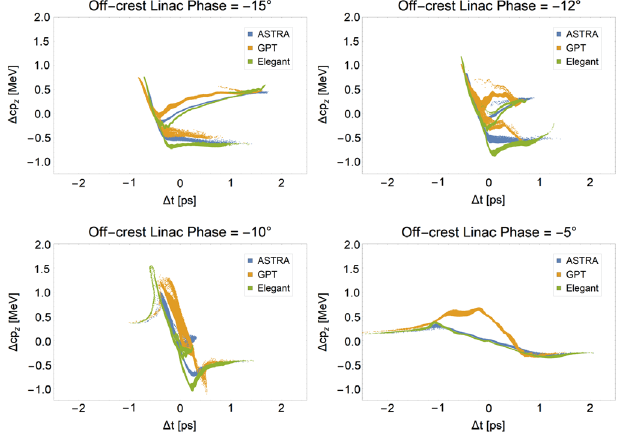
FIG. 8. Comparison of the simulated longitudinal phase space at the BA1 interaction point between ASTRA , ELEGANT , and GPT for various linac 1 off-crest phases, with both space-charge forces and CSR effects included in ELEGANT and GPT . The ASTRA model does not feature CSR.